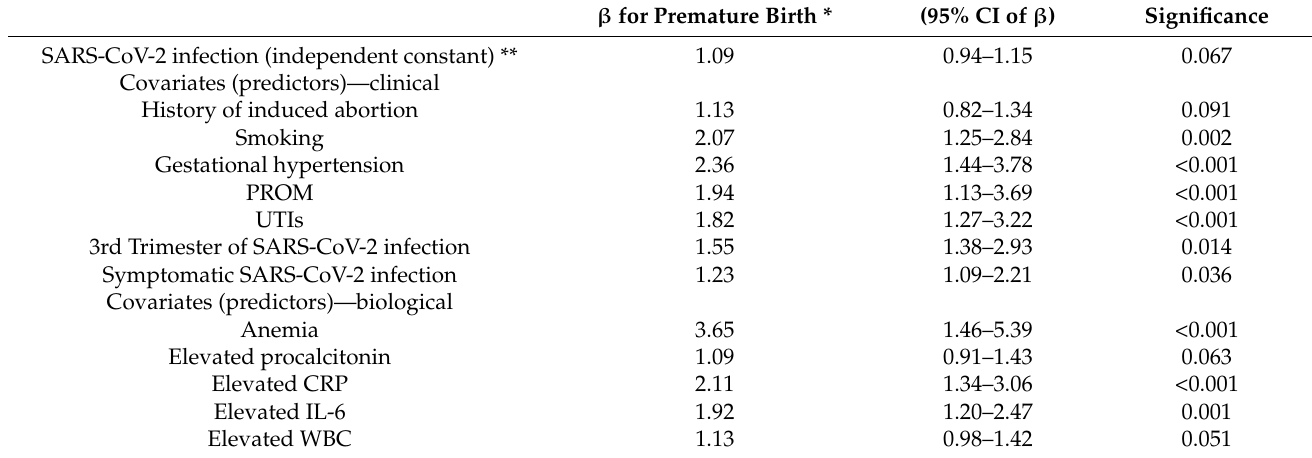
Table 6. Regression analysis for risk of premature birth in SARS-CoV-2 infected pregnant women. β for Premature Birth * (95% CI of β